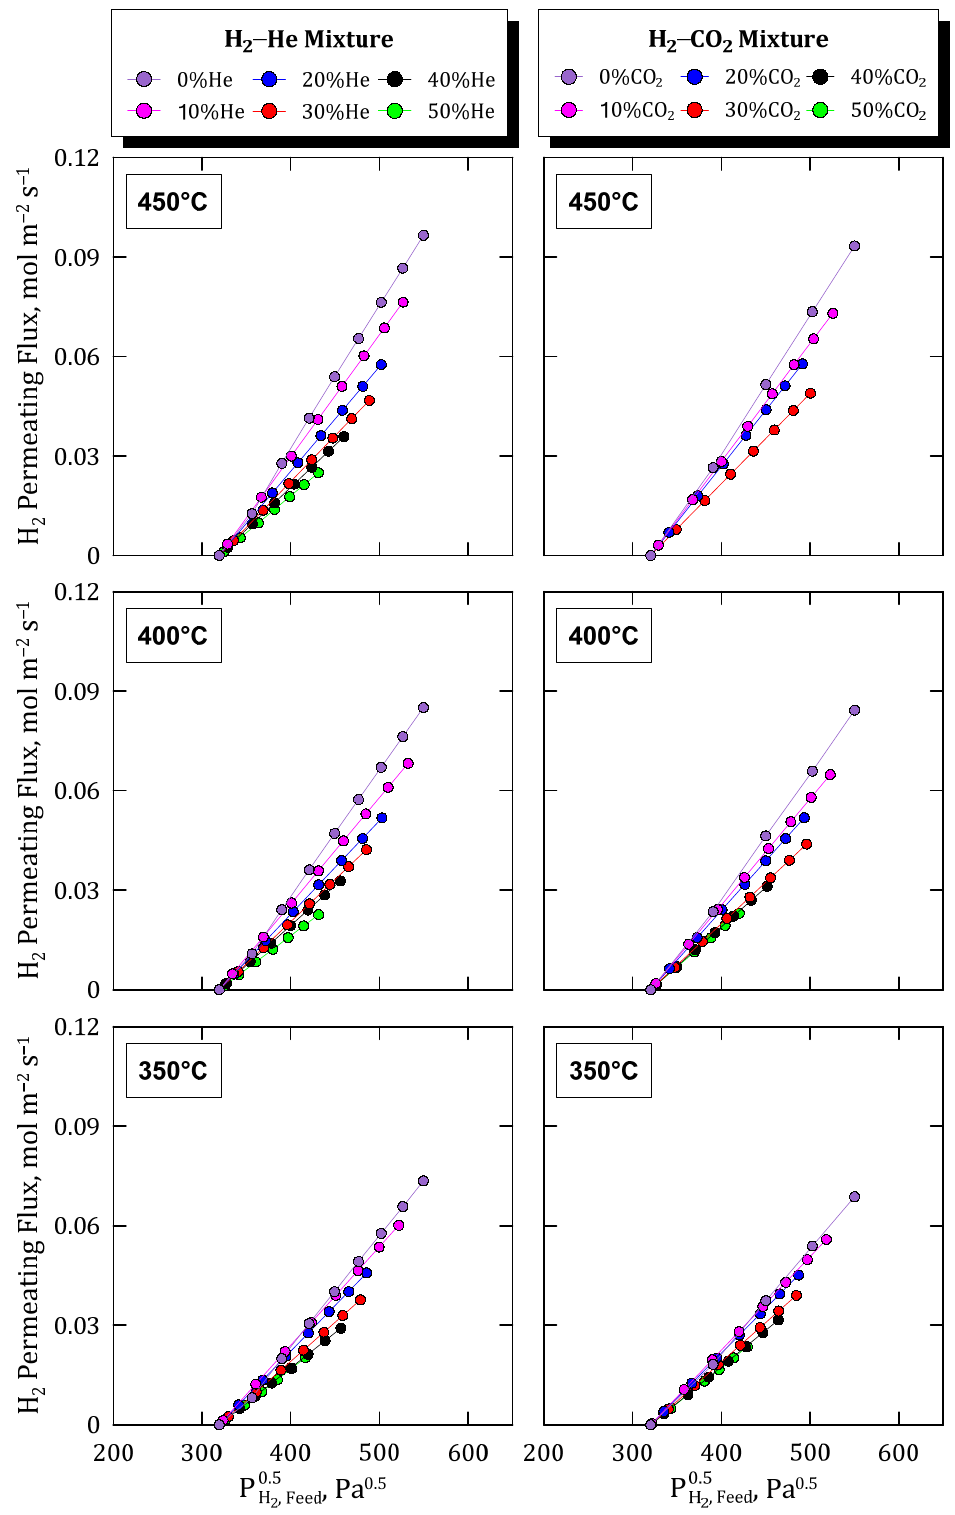
Figure 10. Hydrogen permeating fluxes reached at different temperatures and feed concentrations in H 2 –He and H 2 –CO 2 binary mixtures. H 2 –He and H 2 –CO 2 binary